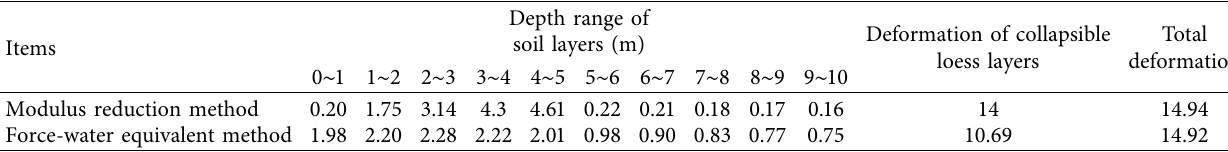
Figure 7: Numerical model (units: m): (a) grid and mesh and (b) distribution of soil Table 4: Compressive deformation of soil layers at different depths (unit: mm).